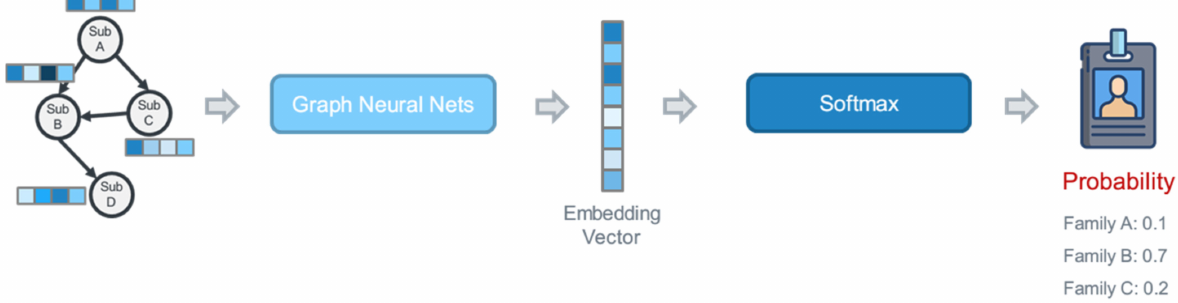
Figure 6. Proposed classification